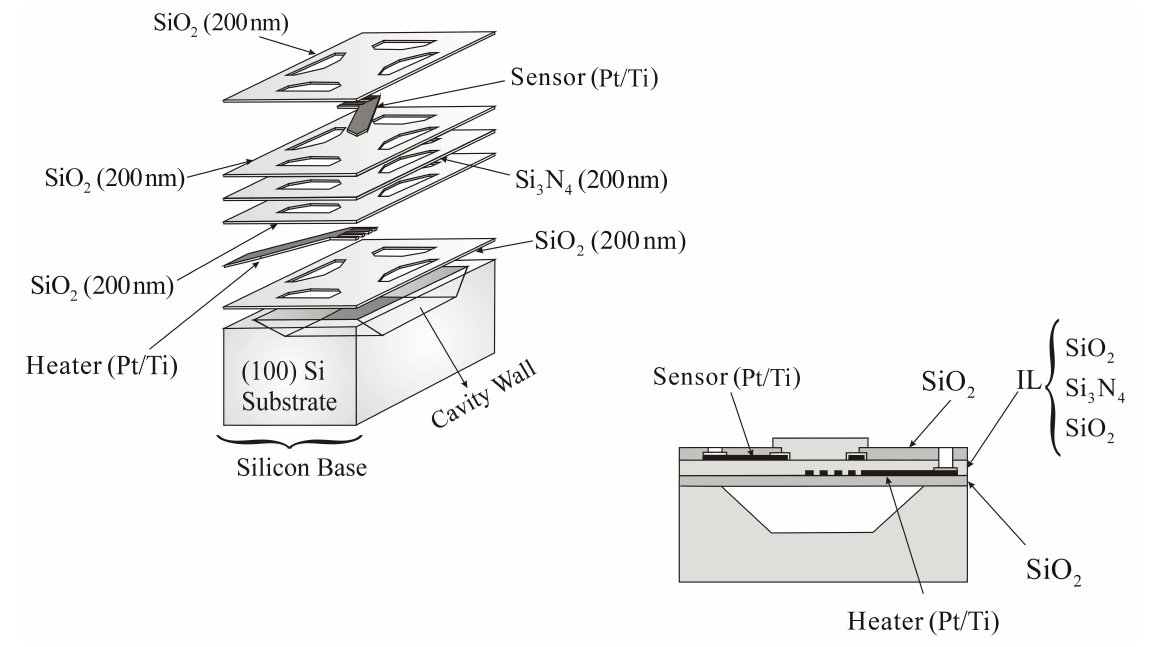
Figure 1. Schematic view of microheater gas sensor